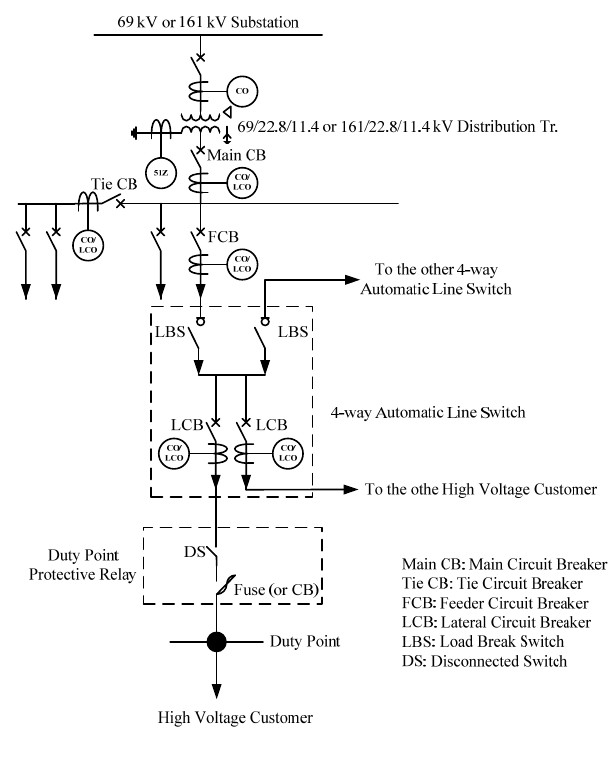
Figure 4. TPC radial distribution systems protection coordination scheme.